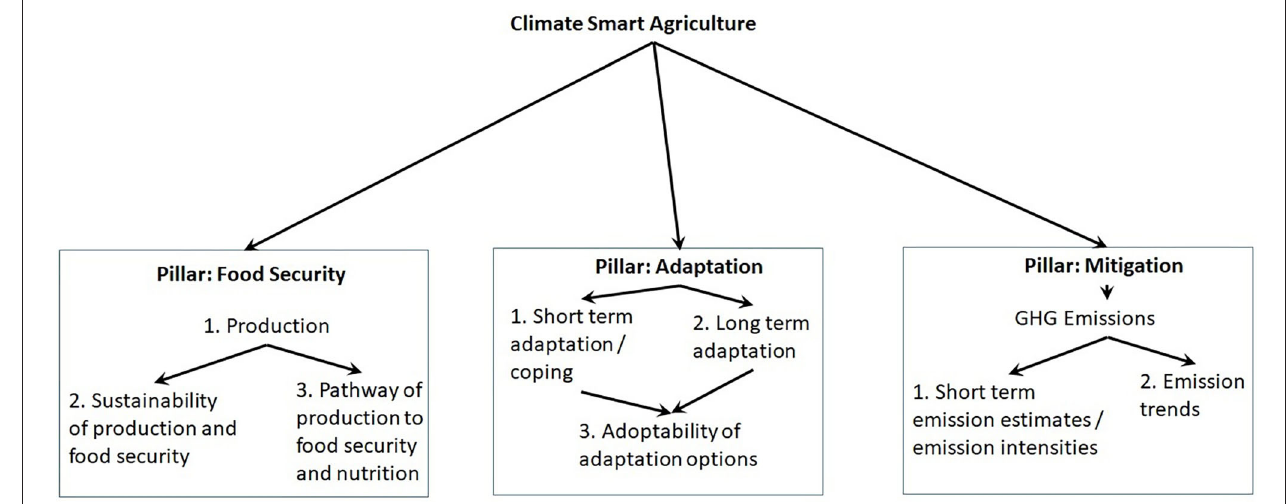
FIGURE 1 | Scheme of the three pillars of CSA and some subcomponents. For explanation of the different aspects see